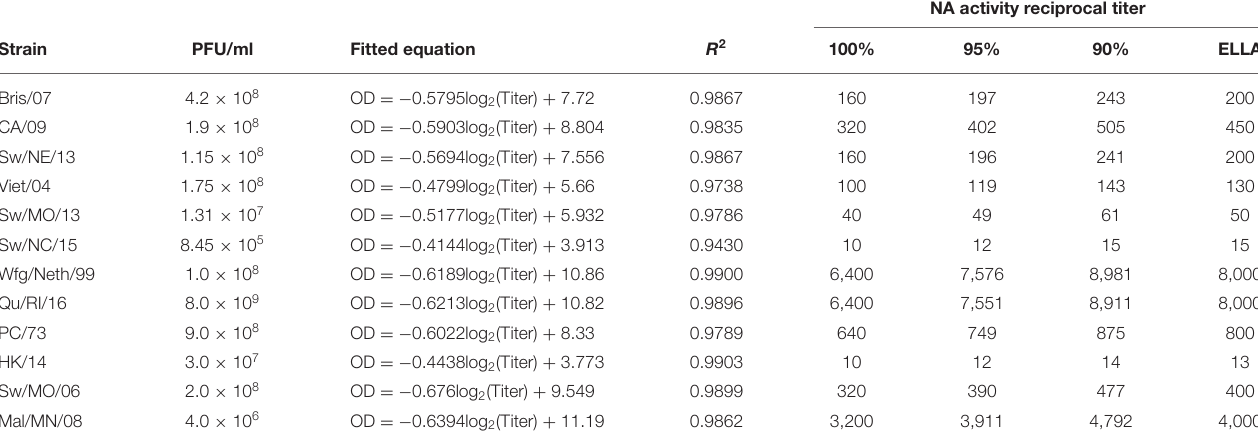
NA activity reciprocal titer